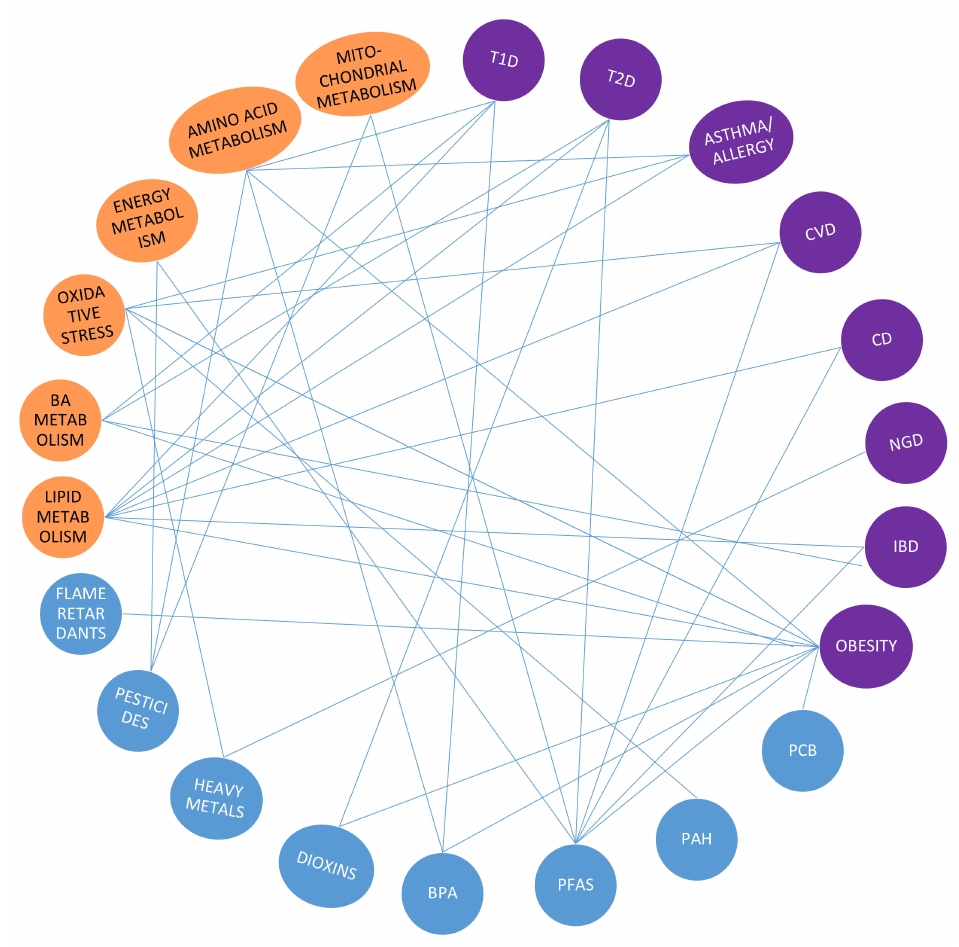
Figure 4. Reported associations between exposure (blue circles), specific diseases (violet circles) and metabolic pathways (orange